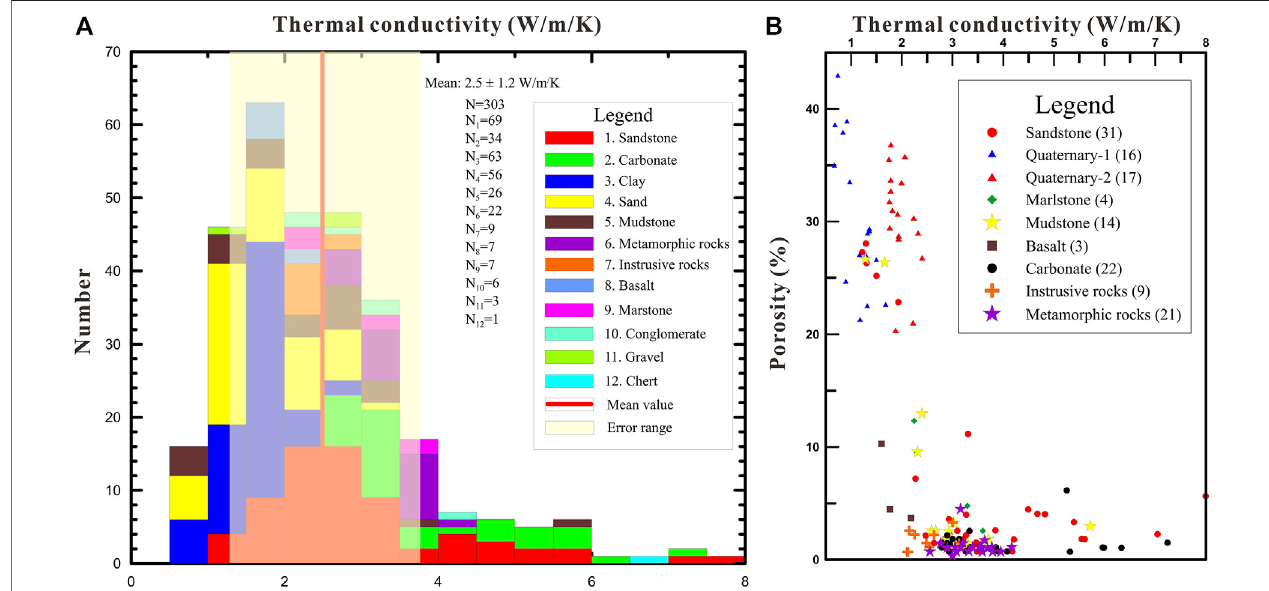
FIGURE 5 | Distribution of thermal conductivity (A) and its relationship with porosity (B) of different rock types in the North Jiangsu Basin.